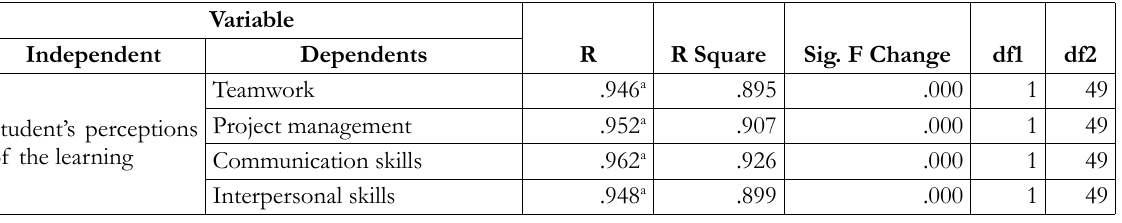
Table 8. The Relationship between positive perception and soft